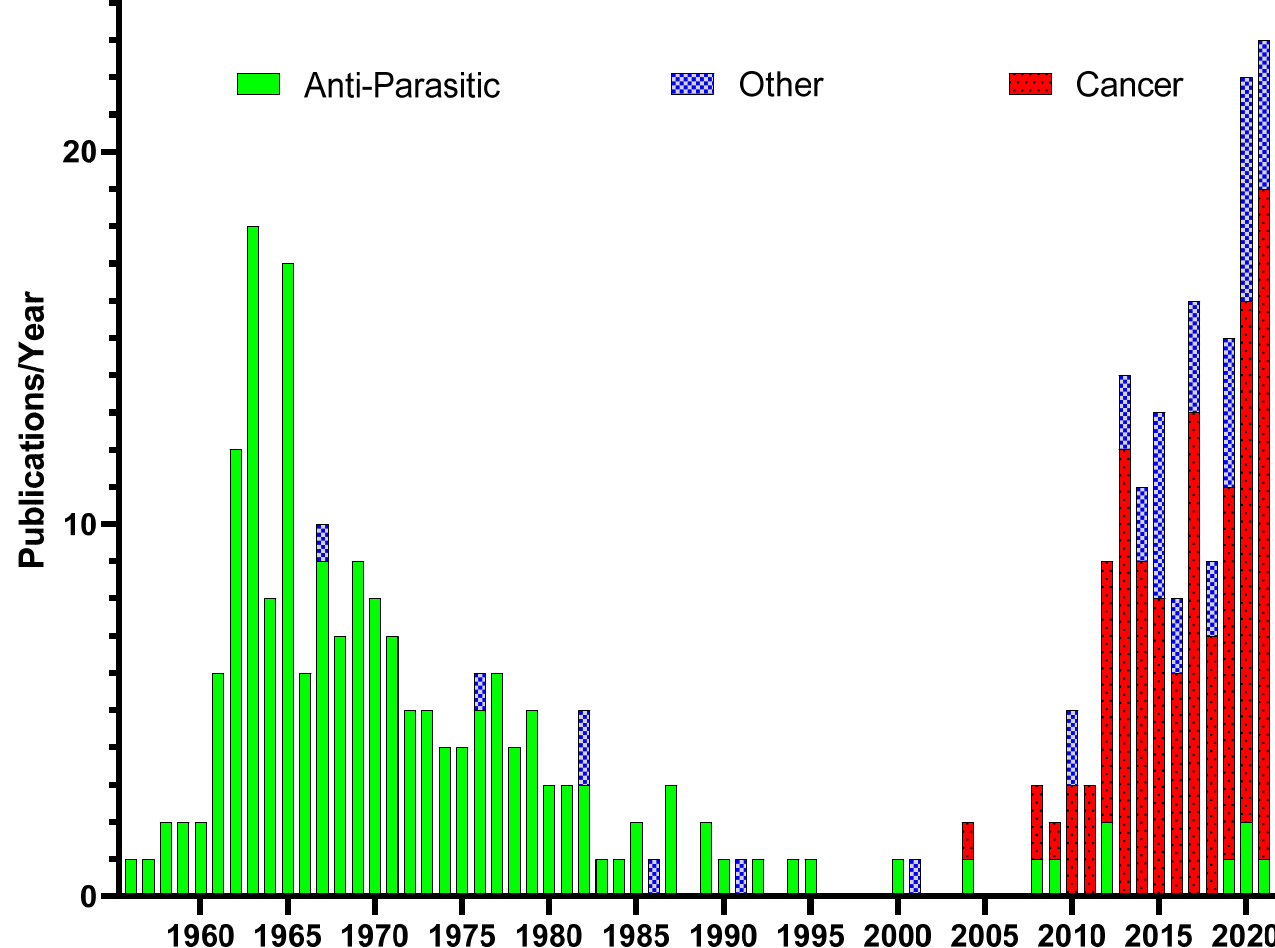
Figure 2. Shifts in pyrvinium pamoate publications over time: PP has been found to be effective in multiple models of human diseases. PP publications/year were broken down by disease type, finding a focus mainly in the anthelmintic activity of PP prior to 2004 and a shift of thematic interest in PP as an anti-cancer agent after 2004.